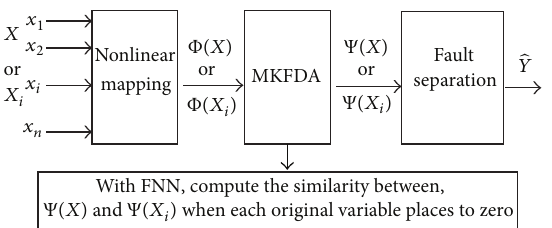
Figure 2: Nonlinear fault diagnosis with redundancy process variables based on FNN in MKFDA